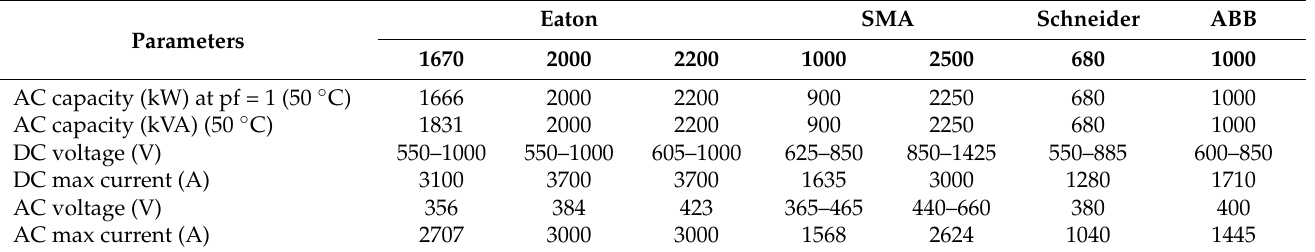
Table 4. Main parameters of some types of inverters in the